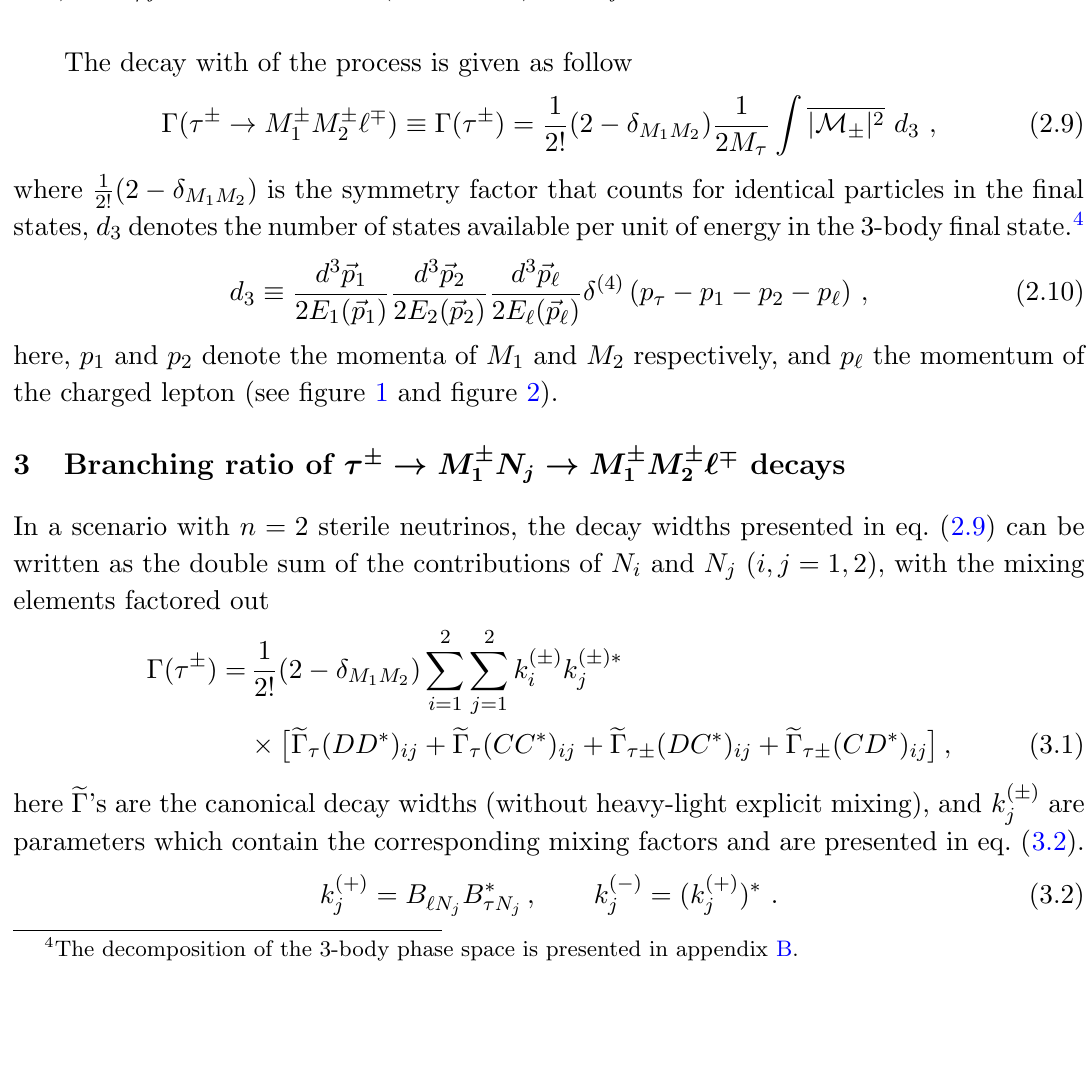
Figure 3 . E(cid:11)ective mixing coe(cid:14)cients. The dashed line (online red) is for N ej , solid line (online blue) for N (cid:22)j and the dotted one (online black) for N (cid:28)j